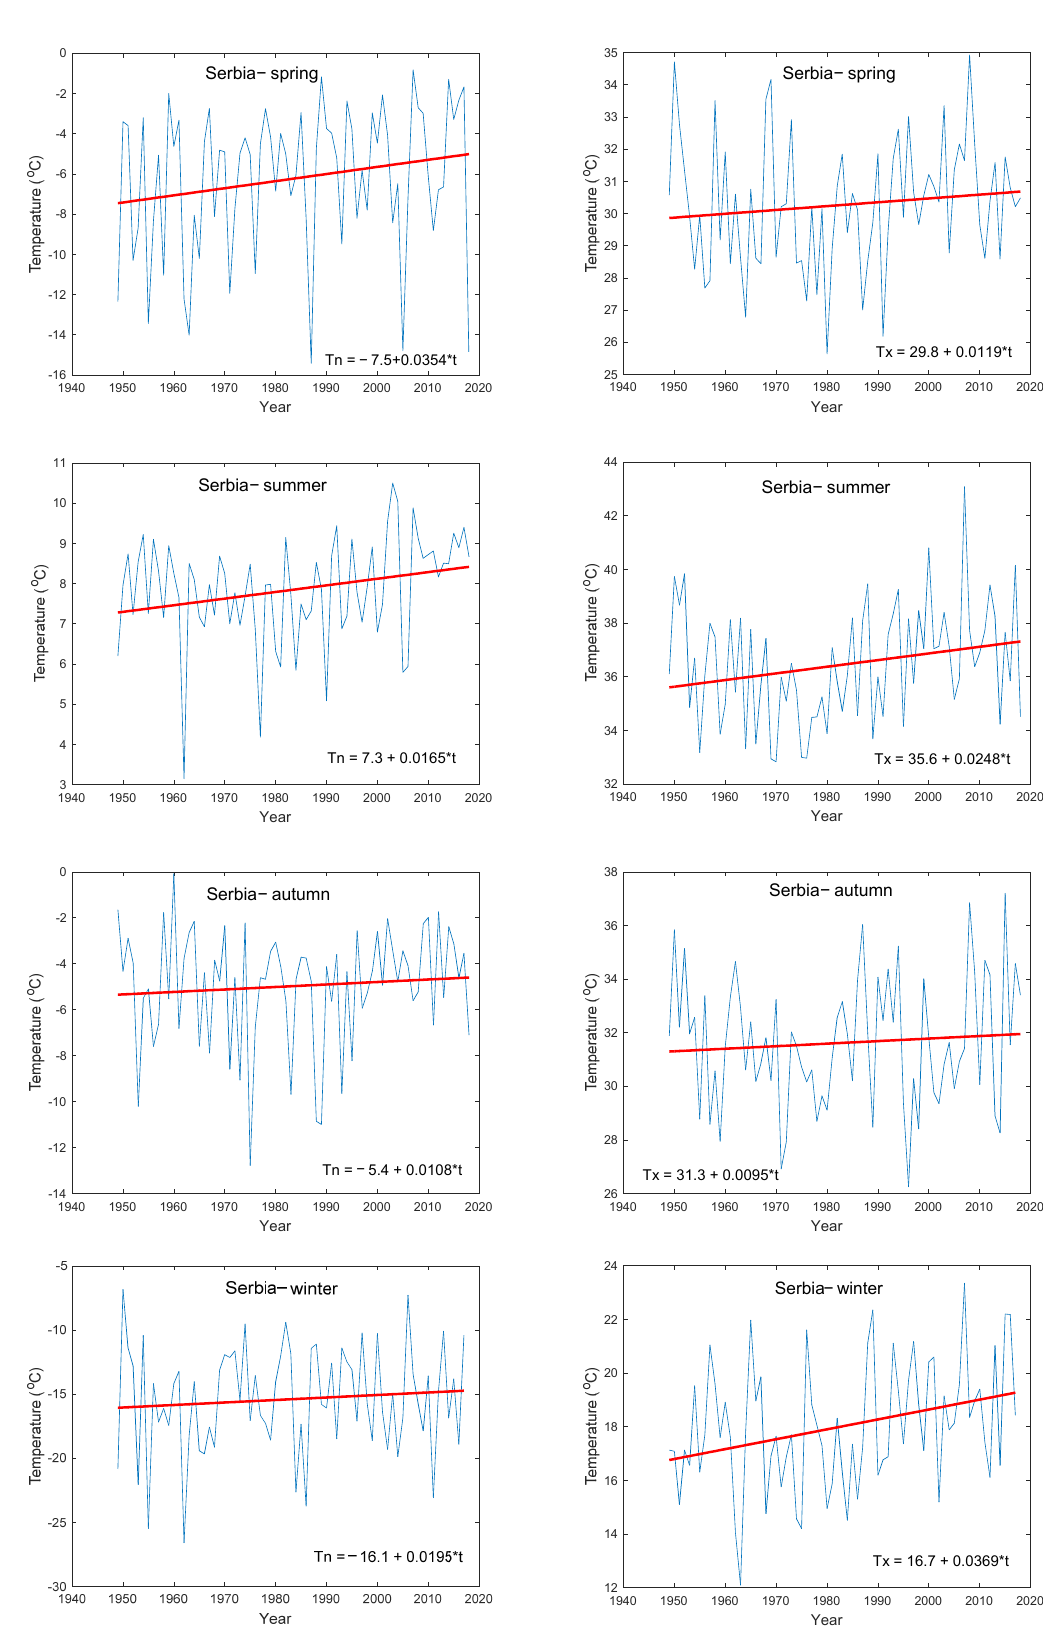
Figure 4. Absolute minimum ( left ) and maximum ( right ) temperatures in Serbia from 1949 to 2018. Straight line represents linear